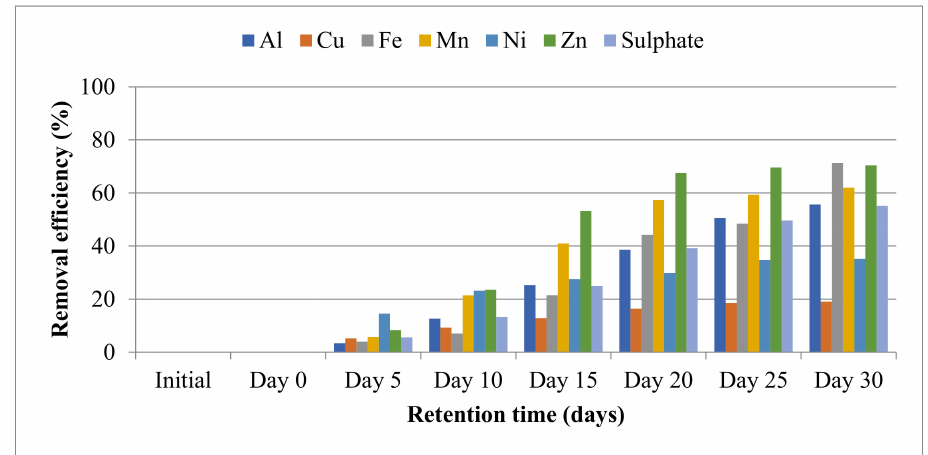
Figure 5. Removal efficiency of heavy metals and sulfate by SSVF in 30 days HRT under a hydraulic loading rate of 3 L/day.